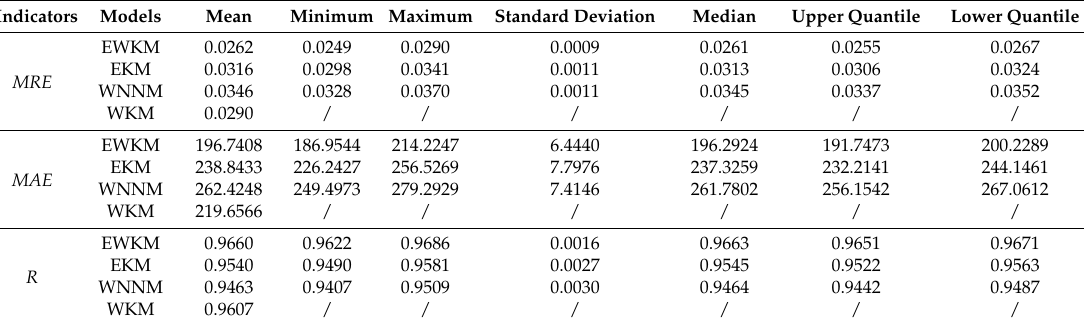
Table 5. Comparing the three criteria of four